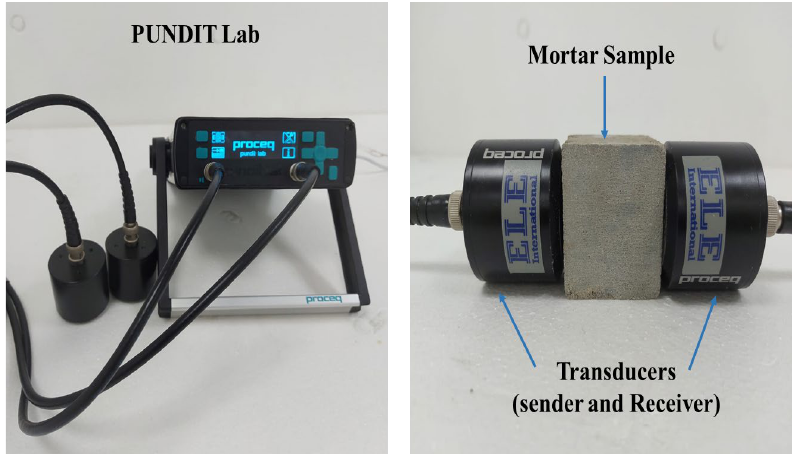
Figure 5. Ultrasonic pulse velocity test setup.